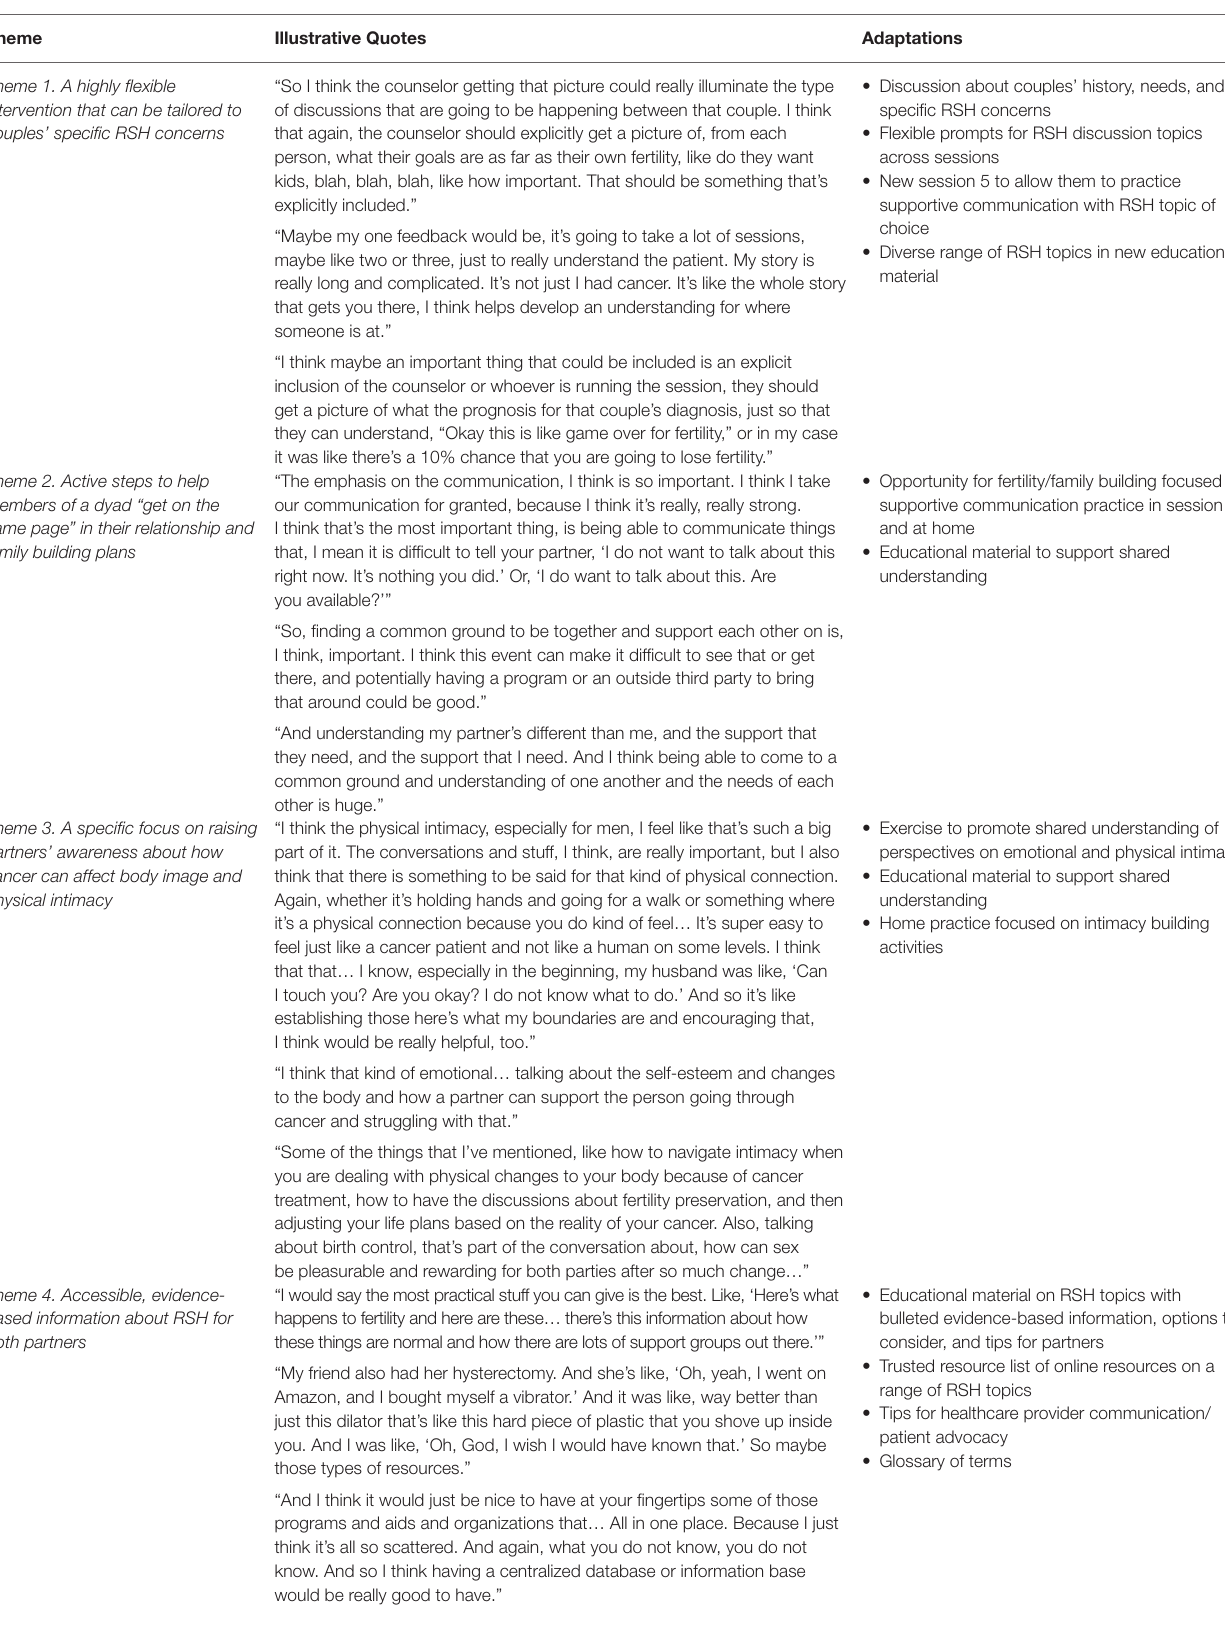
TABLE 2 | Translation of qualitative results to intervention